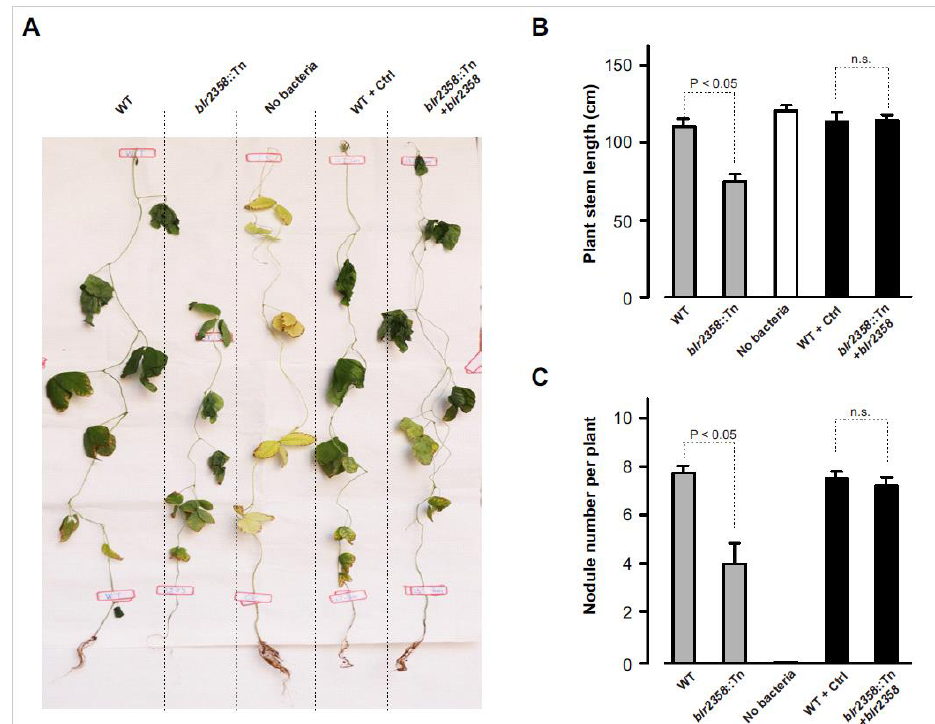
Figure 2. The blr2358 mutant shows reduced nodule formation. ( A ) Representative pictures of soybean cv. Huaxia No. 3 inoculated with B. diazoefficiens USDA110 and indicated mutant strains. Plants were photographed 8 weeks post inoculation. ( B ) Stem length of plants at the time of harvest. ( C ) Number of formed nodules per plant at the time of harvest. Experiments were repeated twice and yielded similar results. Data represent means ± SD ( n = 6, t -test). Abbreviations: WT, wild-type B. diazoefficiens USDA110; blr2358 ::Tn, mutant with Tn5 insertion in blr2358 ; No bacteria, no bacteria were used for inoculation; WT + Ctrl, wild-type B. diazoefficiens USDA110 carrying the empty pBBR1-MCS5 plasmid; blr2358 ::Tn + blr2358 , the blr2358 ::Tn mutant carrying pBBR1-MCS5- blr2358 .